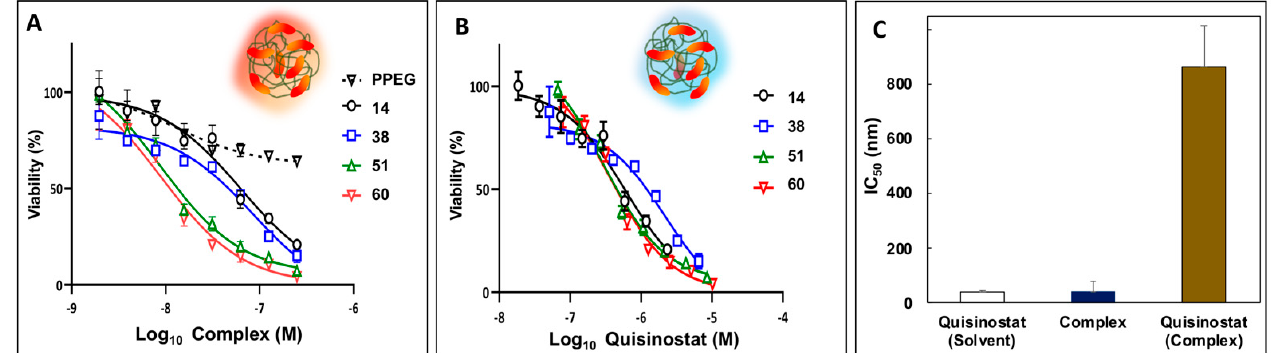
Figure 4. Potency of quisinostat-PPEG complexes in A549 lung cancer cell viability experiments: ( A , B ) Dose–cell viability curves for quisinostat-PPEG complexes and PPEG plotted as a function of complex/polymer ( A ) or quisinostat ( B ) concentrations (numbers indicate quisinostat to polymer ratios in the complexes (mol/mol)); ( C ) half maximal inhibitory concentrations (IC 50 ) calculated relevant to concentrations of quisinostat formulated in DMSO-water mixture (“quisinostat-solvent”), concentration of entire complex containing multiple quisinostat molecules (“complex”—panel ( A ) data, average), and individual quisinostat molecules in a complex—“quisinostat-complex”—from panel ( B ) data (72 h; n = 3; points represent the mean values with errors indicating standard deviation; respective IC 50 values, 95% confidence intervals of IC 50 values, and goodness of fit (R 2 ) of individual curves are shown in Appendix B, Tables A1 and A2).